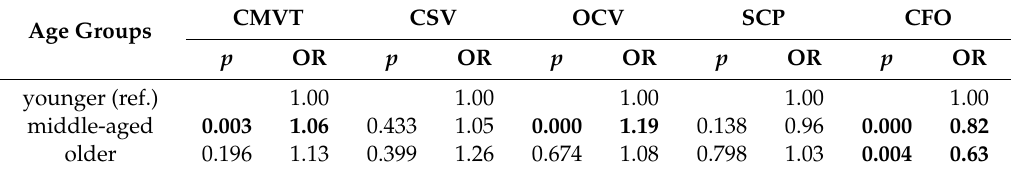
Table 7. Odds ratio results for di ff erent crash types between the examined age groups based on the data before using SMOTE +